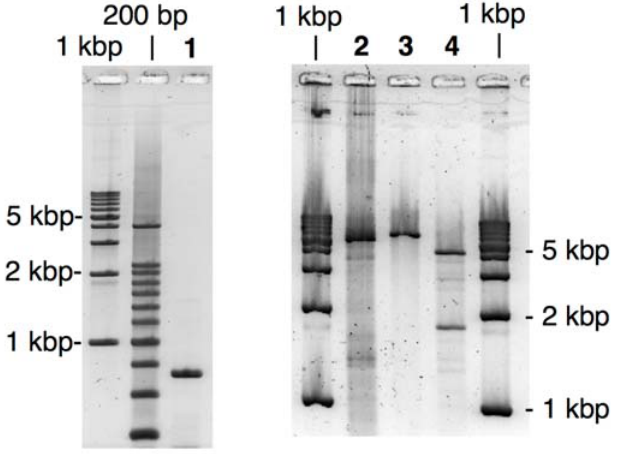
Figure 4. Agarose-gel analysis of LACE-PCR product and the extracted recombinant plasmid for the fusion recombinant. Lane 1, ORF fragment of BFP; Lane 2, the vector fragment; Lane 3, the fusion recombinant linearized with EcoRI ; Lane 4, the fusion recombinant treated with EcoRI and NheI